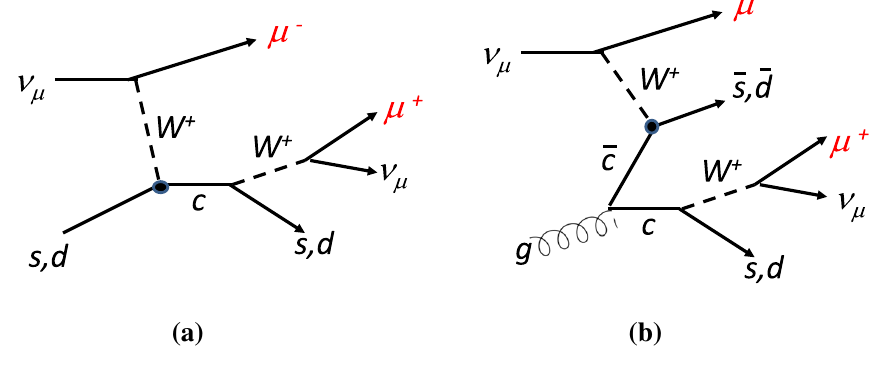
Fig. 3 Diagrams for a light quark and b charm-initiated dimuon production in ν μ N